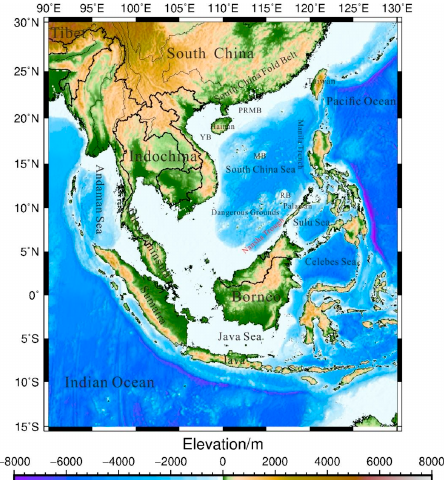
Figure 1. Sketch of the tectonic and topographic map of Southeast Asia. The meanings of the abbreviations in the figure are: PRMB, Pearl River Mouth Basin; YB, Yinggehai Basin; MB, Macclesfield Bank; RB, Reed Bank.